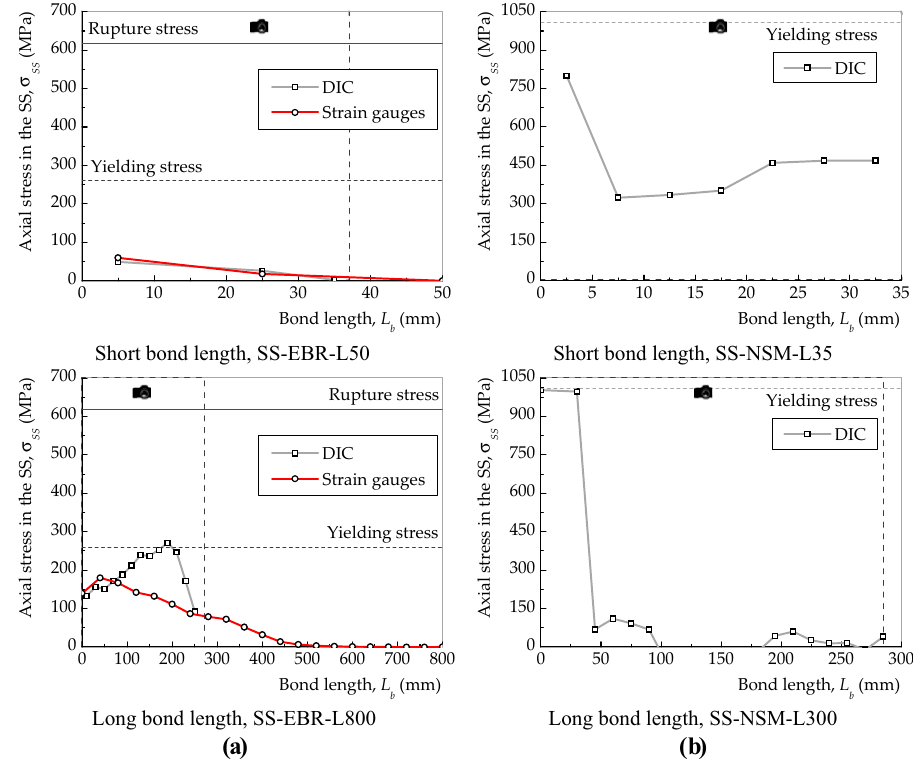
Fig. 11 Stresses developed in the stainless steel obtained from: a EBR samples; and b NSM samples.